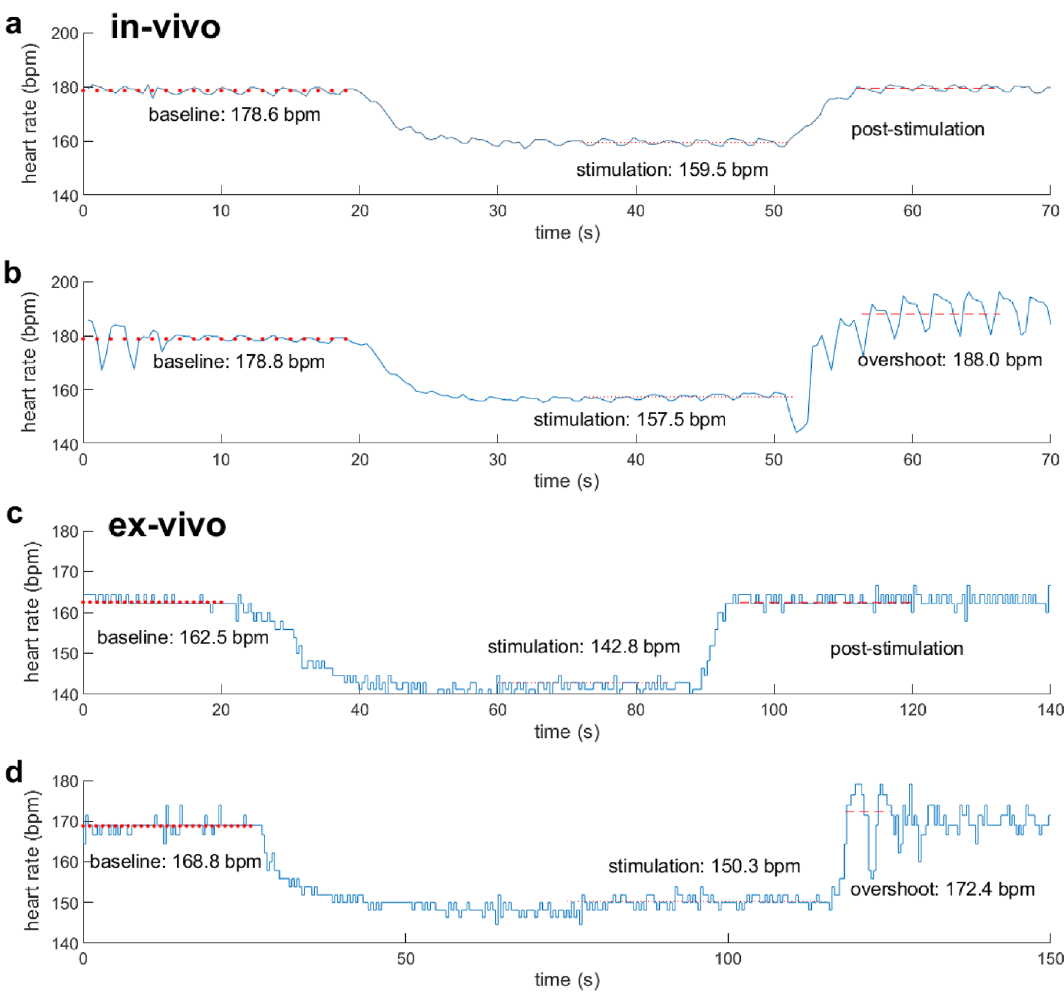
Figure 8. Representative ECG recordings for in-vivo ( a,b ) and ex-vivo VNS ( c,d ), each represented without and with overshoot. Curves a and c represent the ECG curves without overshoot in-vivo ( a ) and ex-vivo ( c ), respectively (“post stimulation”). Curves ( b,d ) represent the ECG curves with overshoot in-vivo ( b ) and ex-vivo ( d ), respectively after stimulation was turned off. The onset of stimulation is demonstrated by the decrease of heart rate in this ECG, whereas the stop of the stimulation is highlighted increasing heart rate. Overshoots are defined as an immediate increase of heart rate by at least 5 bpm above baseline after stimulation was turned off, followed by a return of heart rate back to the actual